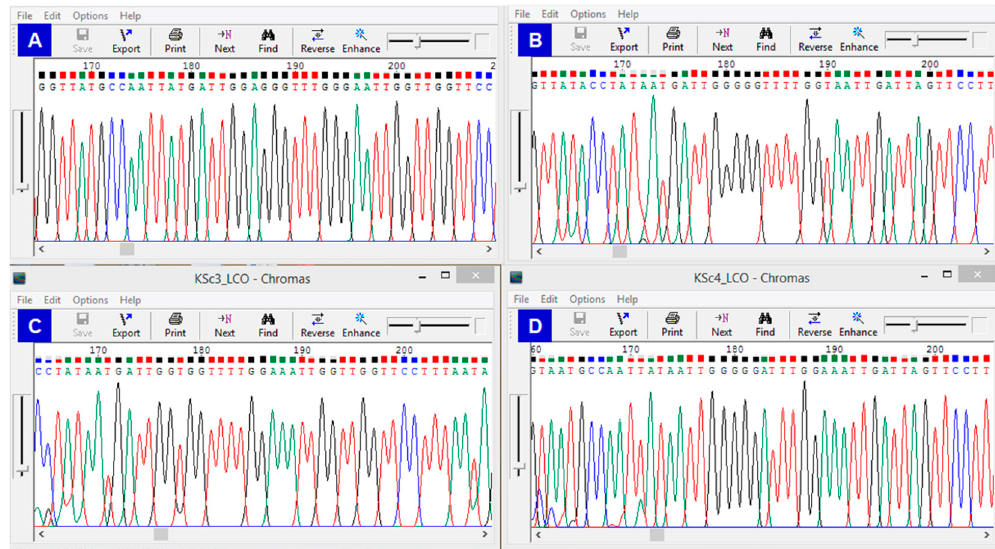
Figure 4. COI sequences’ chromatograms for Leiurus quinquestriatus ( A ), Androctonus amoreuxi ( B ), Orthochirus Innesi ( C ), Buthacus leptochelys ( D ). Red peaks: Thymine, Green peaks: Adenine, Blue peaks: Cytosine, Black peaks: Guanine.